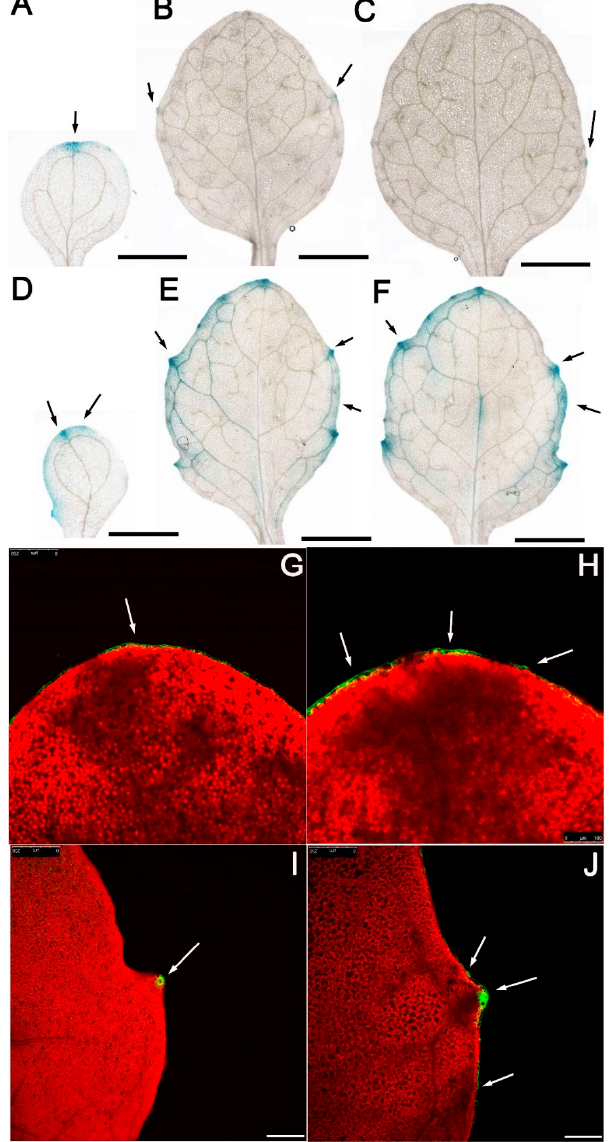
Figure 4. Auxin accumulation monitored by GUS staining and confocal microscopy in ibr5-3 . ( A – C ) Representative images of GUS staining for 10-day-old DR5-GUS transgenic plants in WT. Bars, 5 mm. From left to right: cotyledon, the third true leaf, and the fifth true leaf. The black arrows indicate the auxin maxima sites. ( D – F ) The representative images of GUS staining for 10-day-old DR5-GUS transgenic plants in ibr5-3 . Bars, 5 mm. From left to right: cotyledon, the third true leaf, and the fifth true leaf. The black arrows indicate the auxin maxima sites. ( G , H ) Representative images of confocal imaging for the third leaf of 10-day-old DR5-GFP transgenic plants in WT. Bars, 100 µ m. The white arrows indicate the auxin maxima sites. ( I , J ) Representative images of confocal imaging for the third leaf of 10-day-old DR5-GFP transgenic plants in ibr5-3 . Bars, 100 µ m. The white arrows indicate the auxin maxima